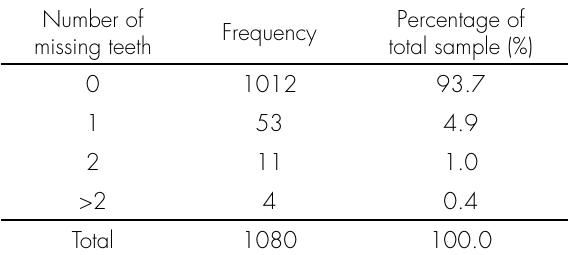
Table II. Number of supernumeraries in each hyperdontia